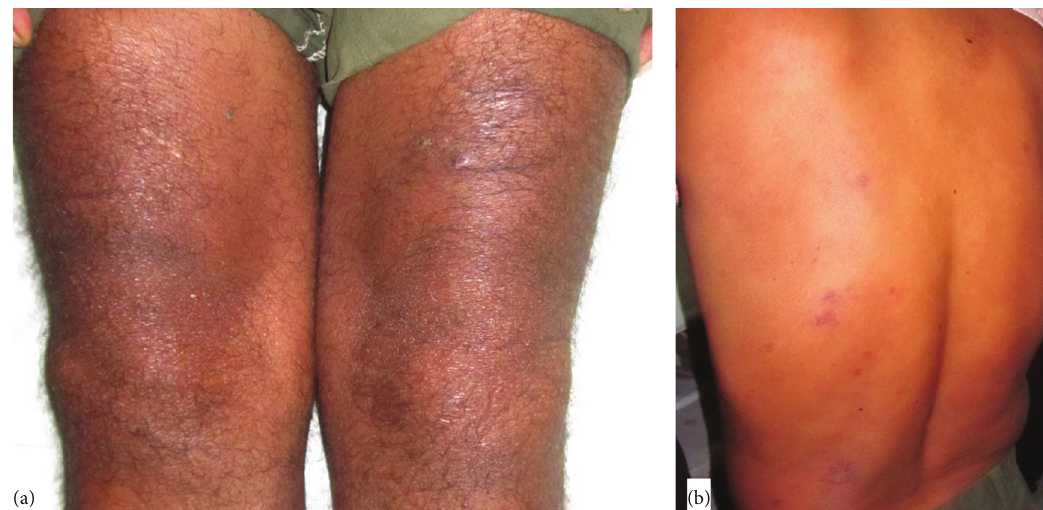
Figure 2: (a) Shiny, plaque lesion over left knee diagnosed as steroid modified psoriasis. (b) Erythematous, plaque like lesions over the back thought to be plaque psoriasis.